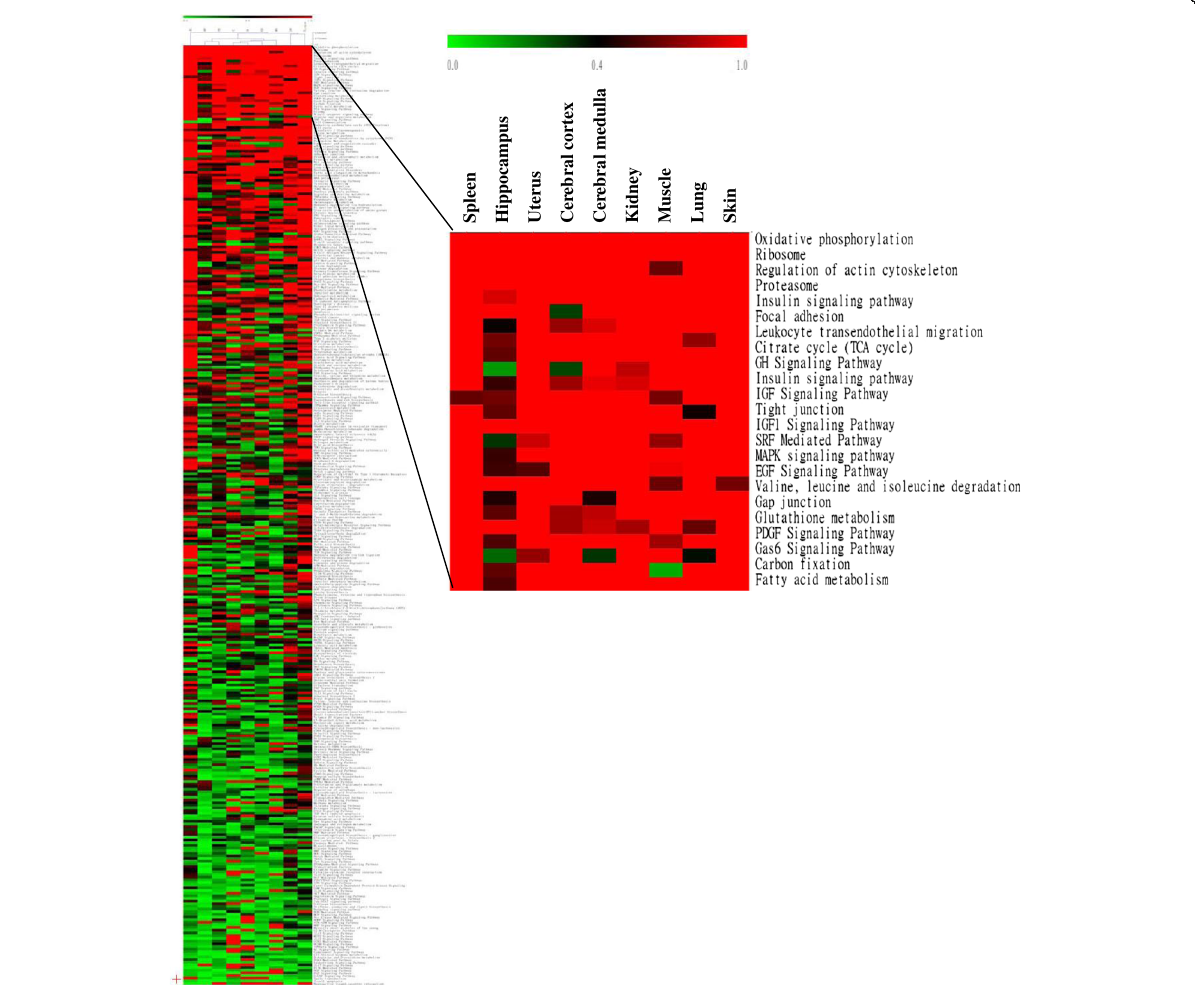
Fig. 2 Hierarchical clustering analysis of biological pathways regulated by EA stimulation at ST36 acupoint in various organs. The score of each pathway is color-coded according to the legend at the top . Top 25 pathways are enlarged and shown on the right